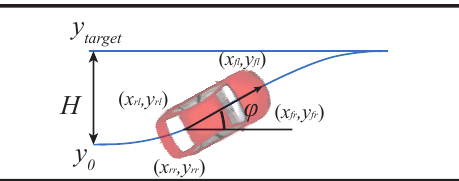
Figure 2. The position of vehicle during the lane-change process.